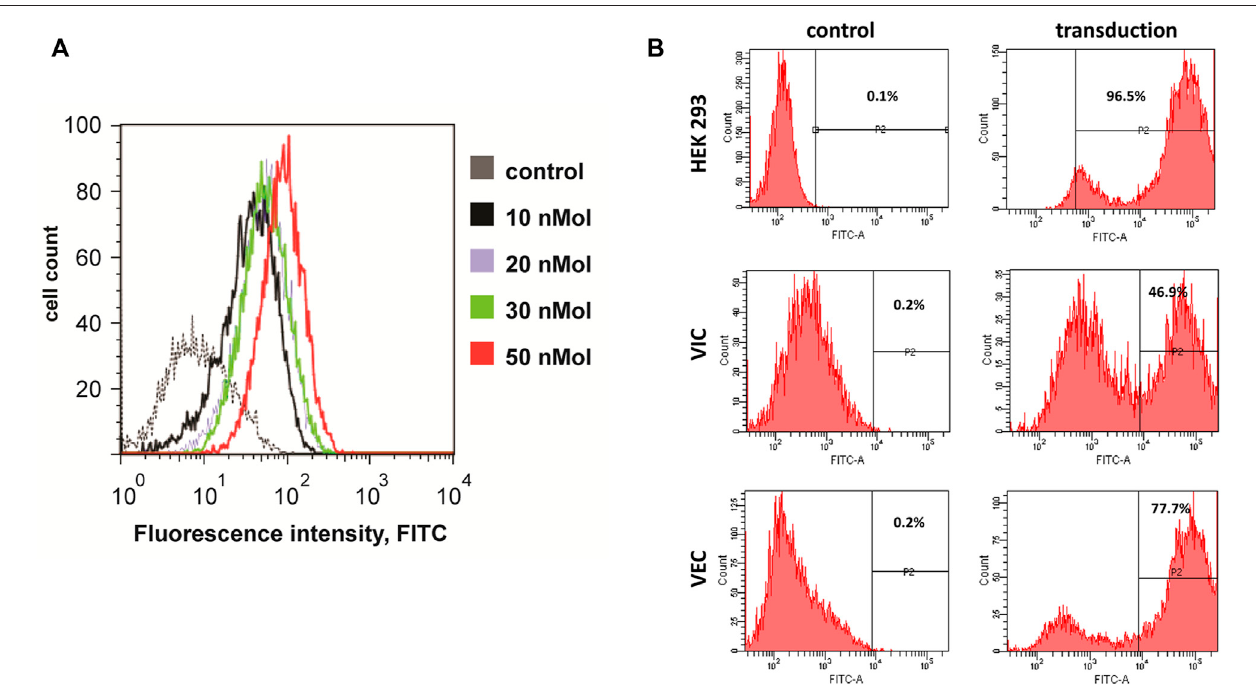
FIGURE 8 | Genetic engineering of valve endothelial (VEC) and interstitial cells (VIC). (A) Representative example of fl uorescence - activated cell sorting (FACS) analysis of VIC from a calci fi ed aortic valve and transfected with siRNA to mRNA conjugated with fl uorescein isothiocyanate (FITC). Transfection kit was used with different concentrations of nanoparticle formulation solution (NFS). Dotted line - negative control (transfected with scrambled siRNA), black line – transfected with 10 nM NFS, blue – 20 nM NFS, green -30 nM NFS, red -50 nM NFS (86.5% of cells transfected with siRNA). (B) Representative example of fl uorescence – activated cell sorting (FACS) analysis of human embryonic kidney cells 293 (HEK293), aortic valve interstitial and endothelial cells from a calci fi ed aortic valve without transduction or transduced with lentiviral construct that encoded green fl uorescent protein (GFP).